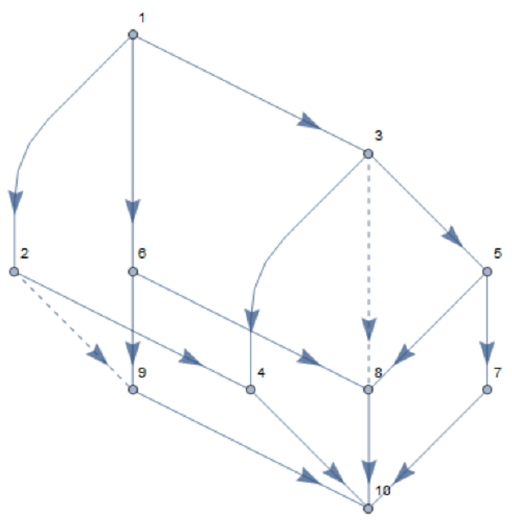
nt cor- g = (cid:11) g